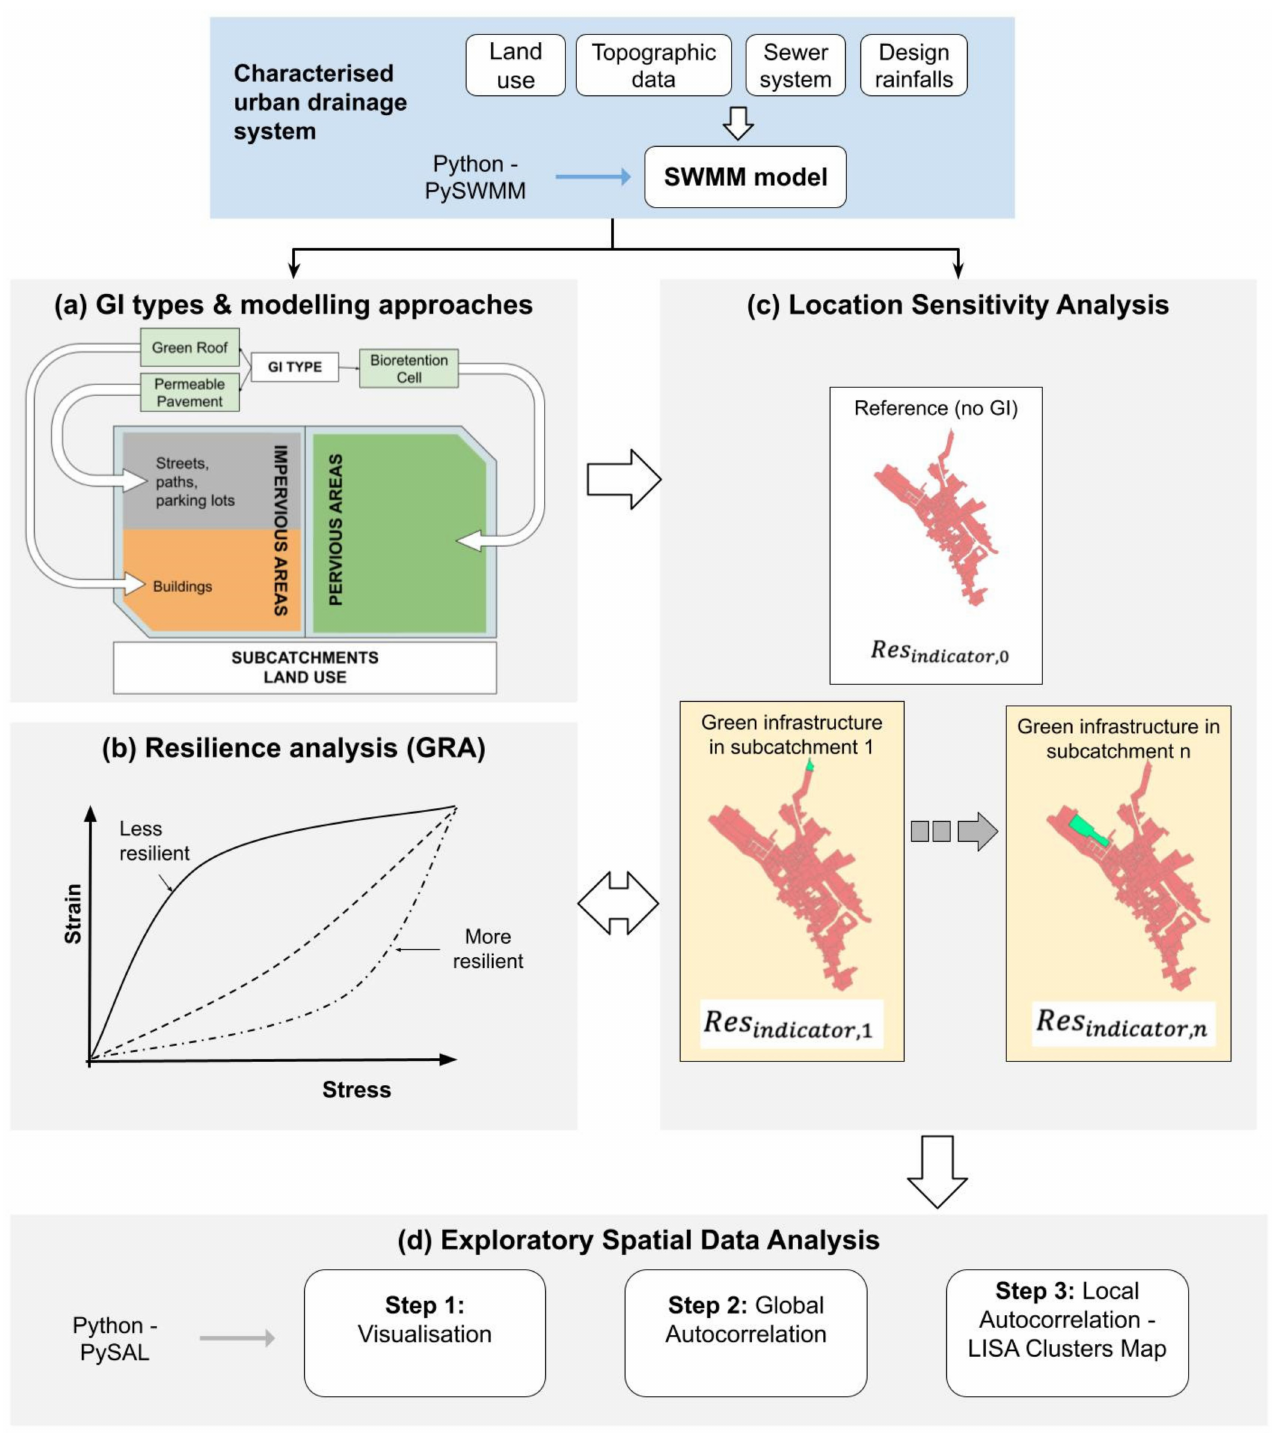
Figure 1. Proposed analysis framework for the application of exploratory spatial data analysis to assess the relationship between green infrastructure (GI) location and resilience enhancement. ( a ) GI types and modelling approach. ( b ) Resilience assessment using Global Resilience Analysis (GRA) (Adapted from [2]). ( c ) Location Sensitivity Analysis. ( d ) Exploratory Spatial Data